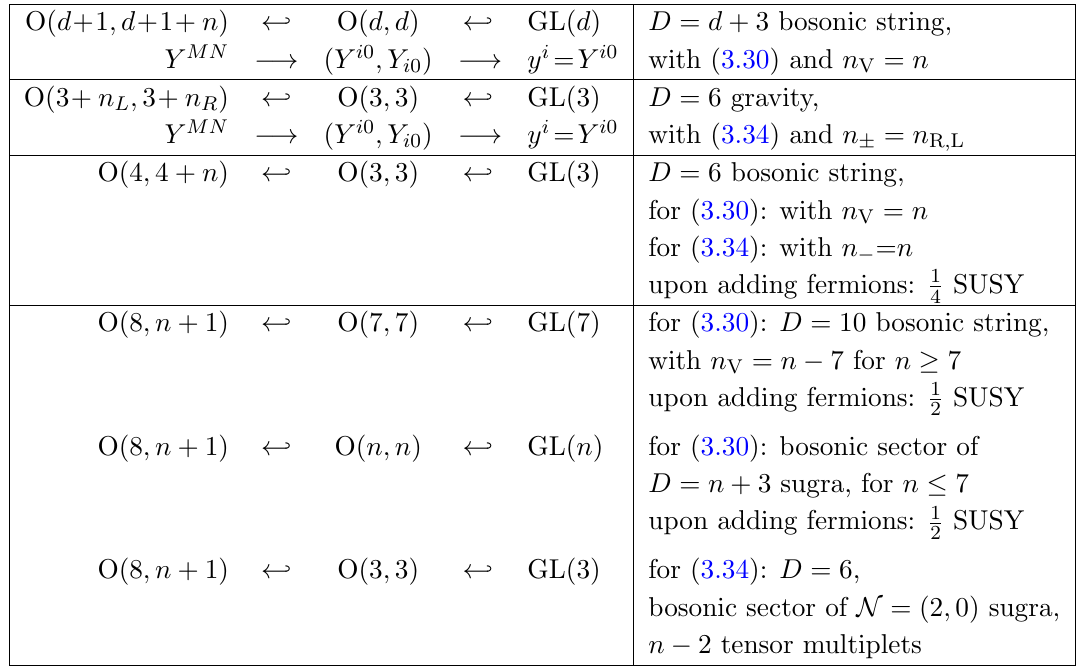
Table 1 . Table of gravitational theories which can be embedded into the present construction together with the corresponding solutions of the section constraint. Notations are the following: n s — number of scalar multiplets, n V — number of abelian vector multiplets, n ± — number of (anti)self-dual